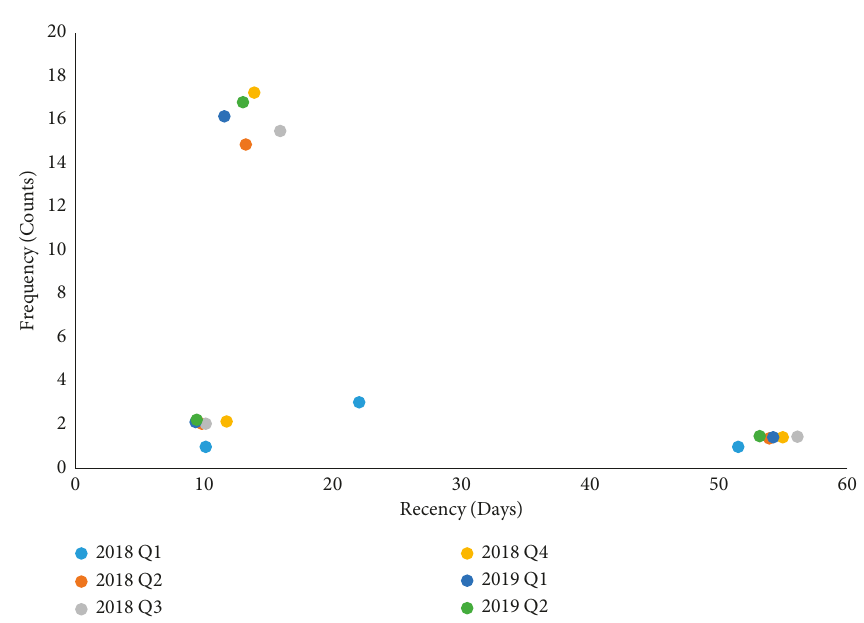
Figure 11: Target segment identification based on transit travellers’ relative recency ( R ) and frequency value ( F ). Points represent clusters 1, 2, and 3 for the 2018 and 2019 quarterly.